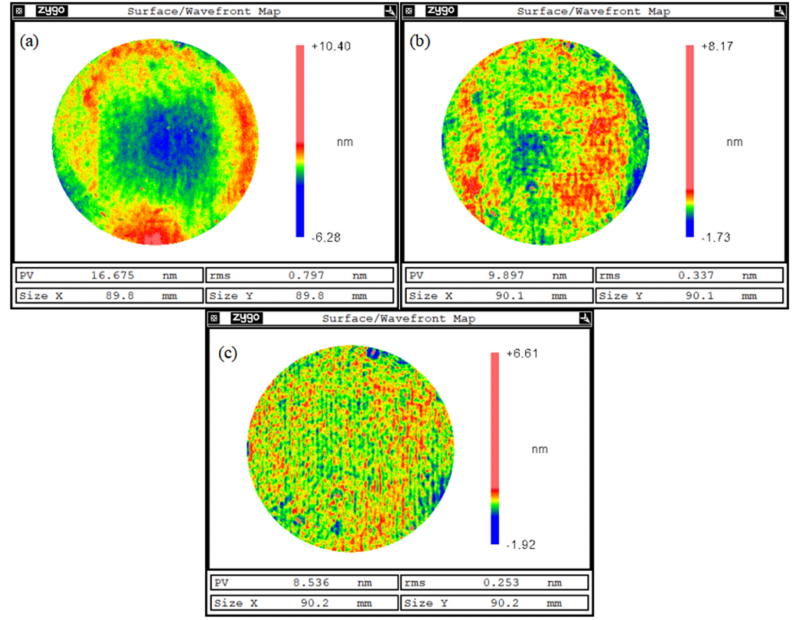
Figure 21. Practical figuring results of ( a ) the first iteration, ( b ) the second iteration, and ( c ) the third